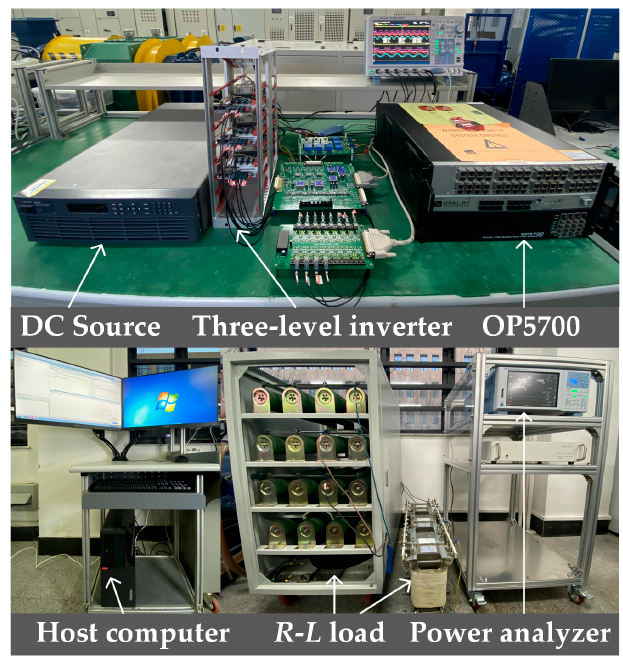
Figure 11. The prototype of OPAL-RT ® OP5700 driven three-level inverter.